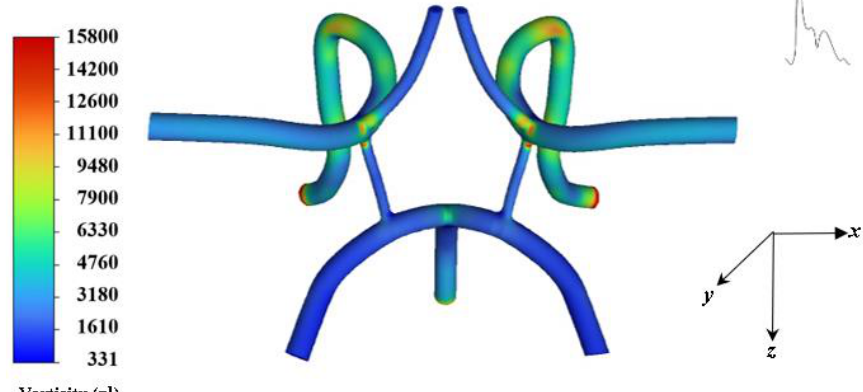
Figure 4. Contour of flow vorticity at systole.